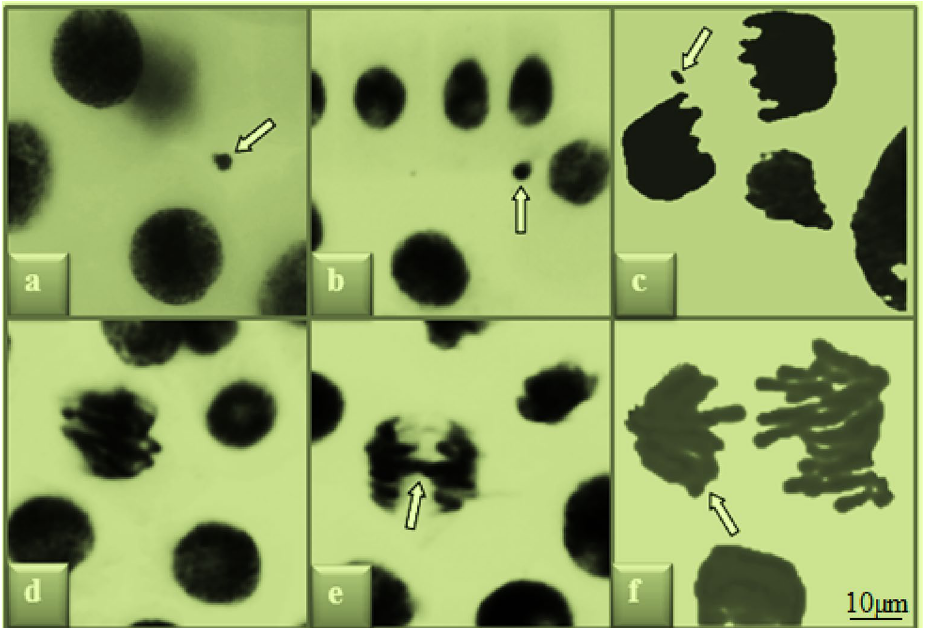
Figure 3. Chromosomal abnormalities induced by glyphosate. MN in interphase ( a , b ), fragment in telophase ( c ), sticky chromosome in prophase ( d ), bridge in anaphase ( e ), unequal distribution of chromatin in anaphase ( f